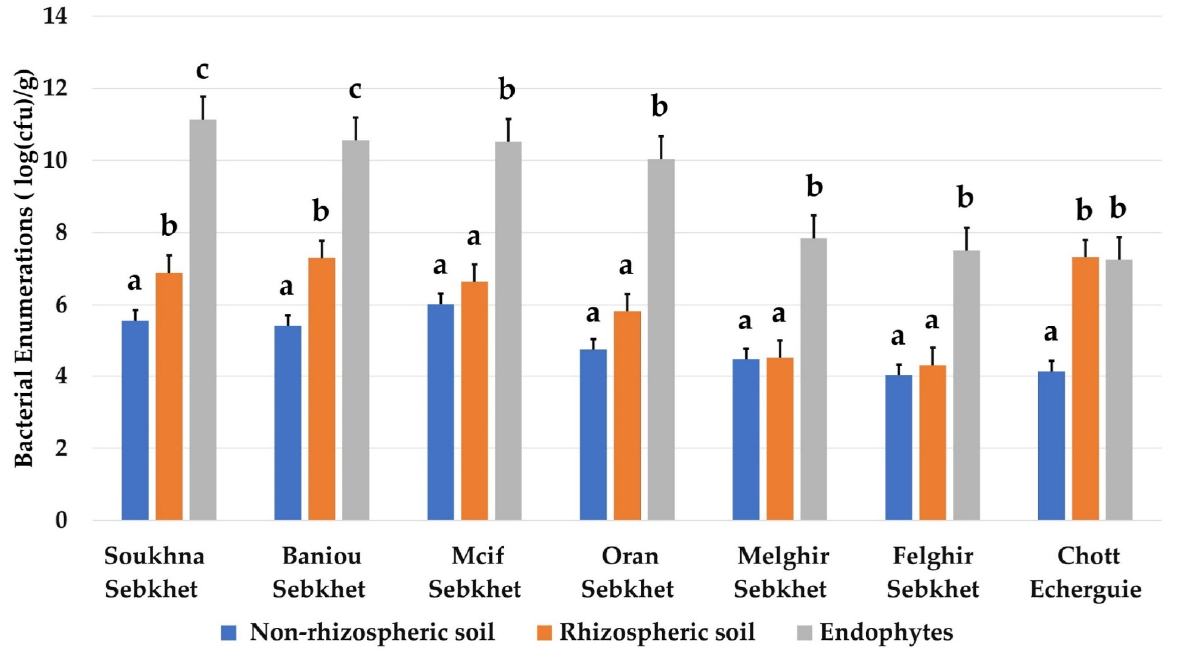
Figure 3. Bacterial enumerations (log(cfu)/g) from different habitats (non-rhizospheric soil, rhizospheric soil, and endophytes) in the seven locations. Data present mean ± standard error. Bars labelled with different letters are significantly different among the treatments at p < 0.05 using Tukey’s HSD test. In each bar groups, bars labelled with the same letter are not significantly different from each other according to Tukey’s HSD at p < 0.05.